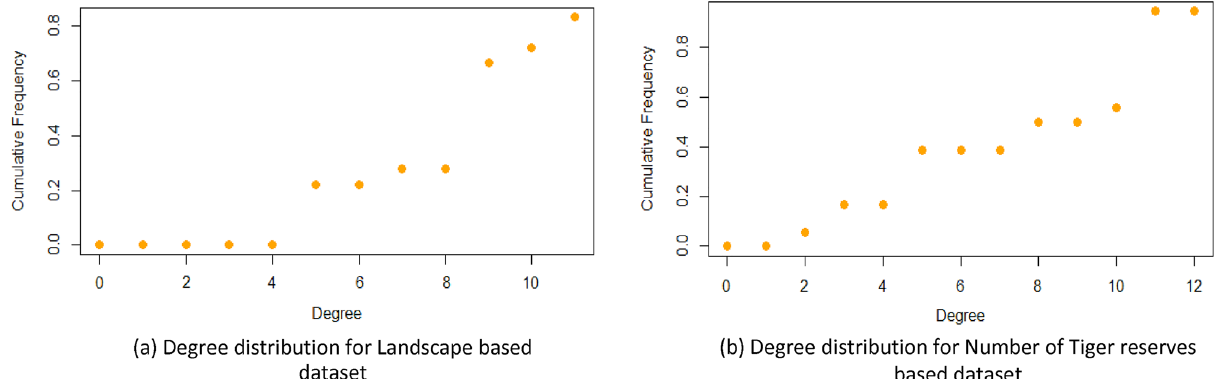
Figure 1. Degree distribution for Landscape based dataset and Number of Tiger reserves based dataset.